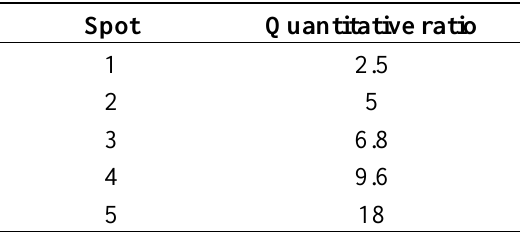
Table 1. Quantitative ratio of relative cathodoluminescence (CL) intensities at room